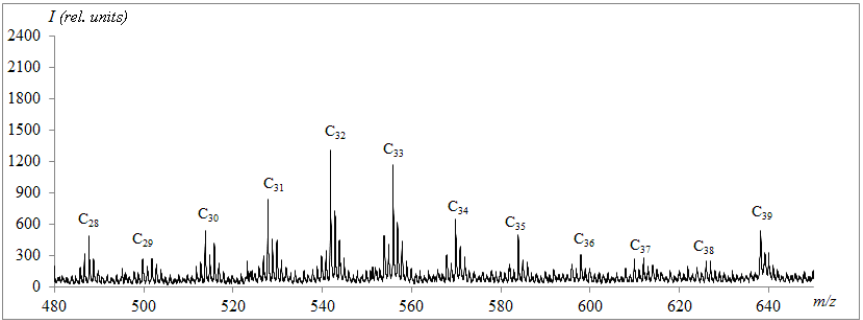
Figure 6. MALDI-TOF mass spectrum of pVP from DMF extract of the resins of HO no. 2.